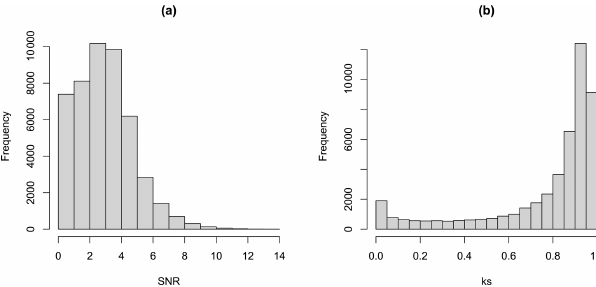
Figure 5. Panel (a) shows the frequency distribution of the SNR values shown in Fig. 1c and panel (b) shows the frequency distribu- tion of the k values shown in Fig.